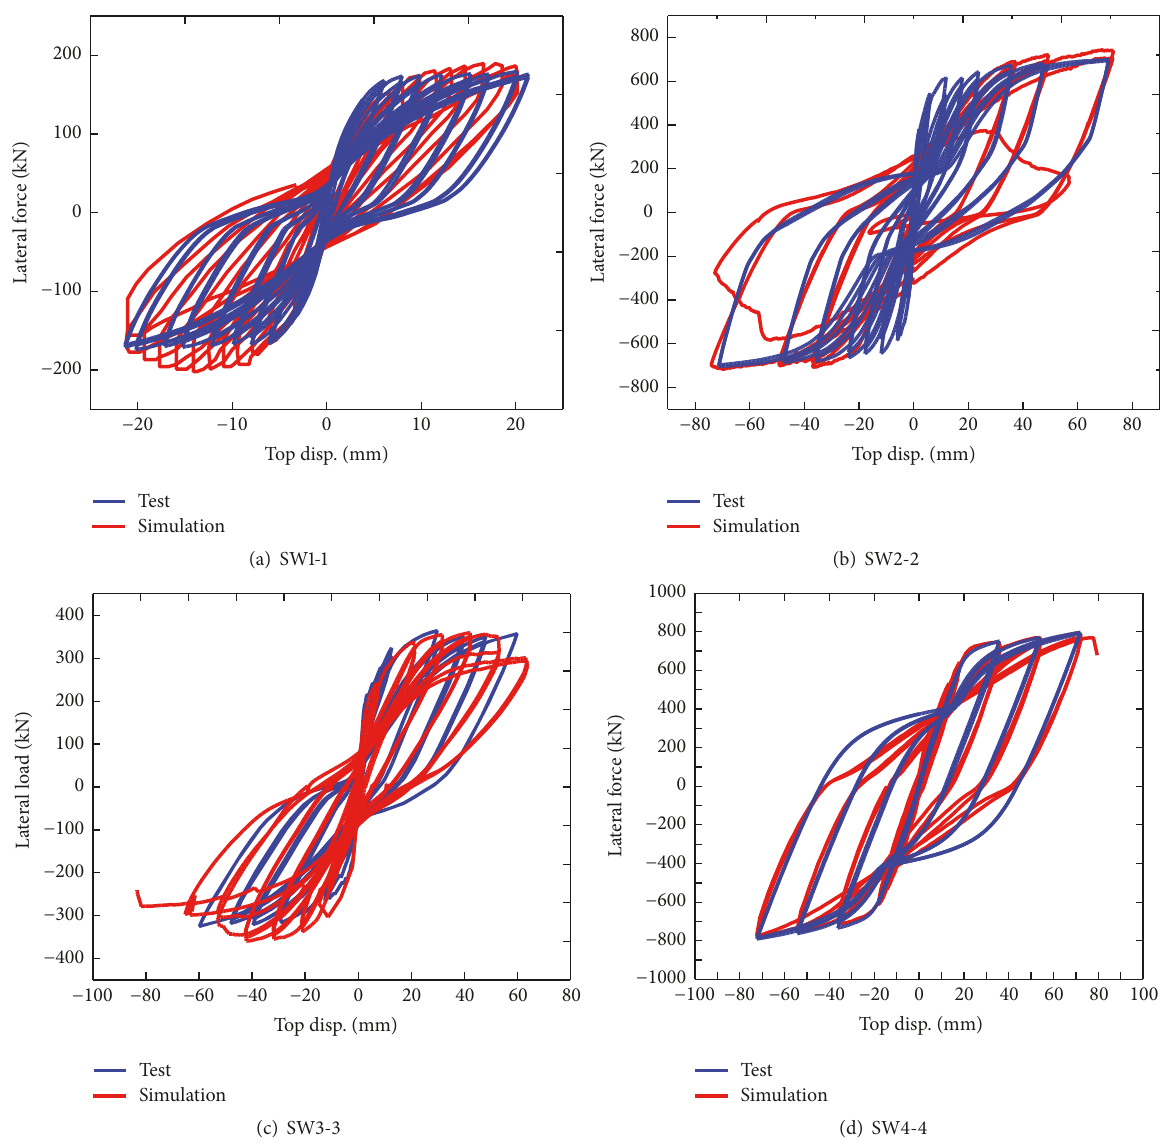
Figure 5: Top force versus displacement hysteretic curve of